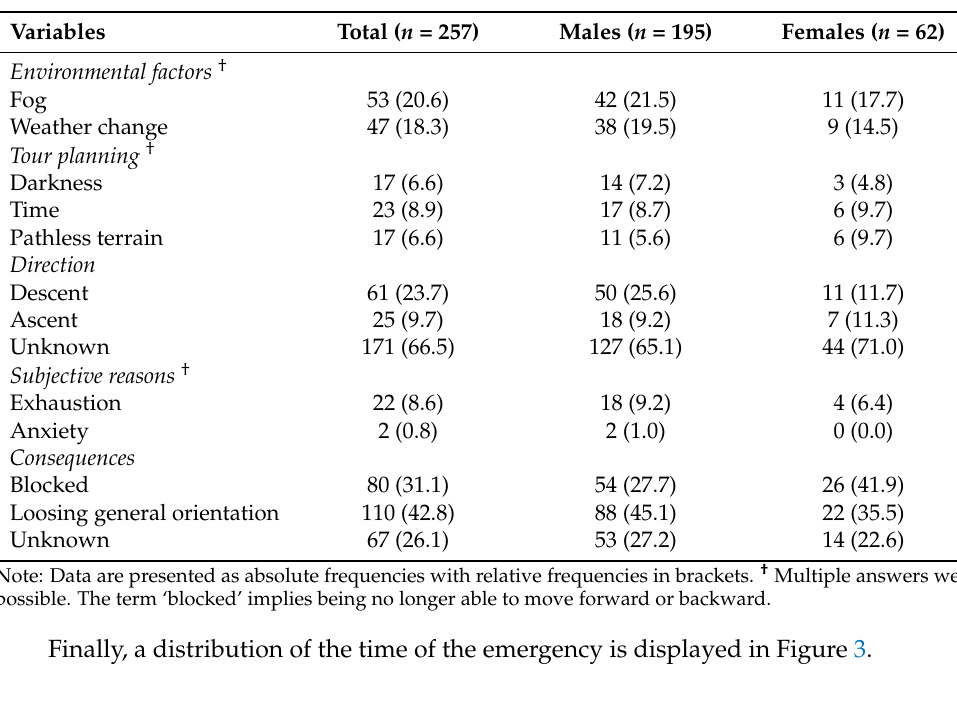
Table 3. Perceived reasons and associated factors with being lost that were extracted from emergency reports stratified by sex. The topic is in italic.